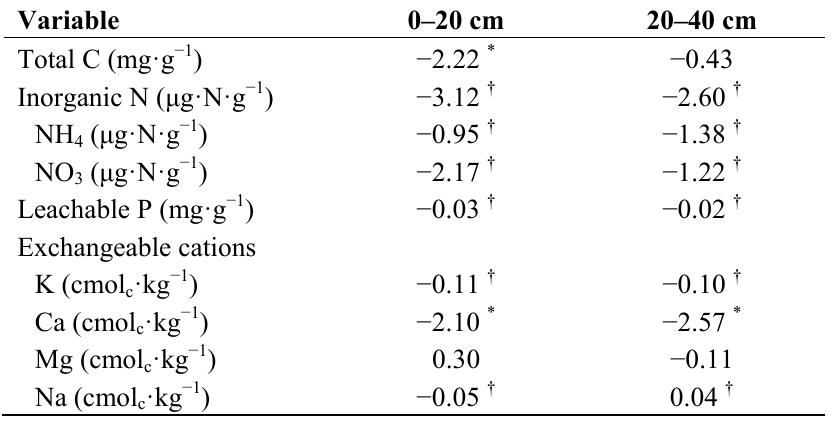
Table 3. Mean pairwise differences between S. purpurea “Hotel” plantation and reference soils for nine sites (ELL, SMO, LAK, UOS, POR, BIR, SSM, GUE, and